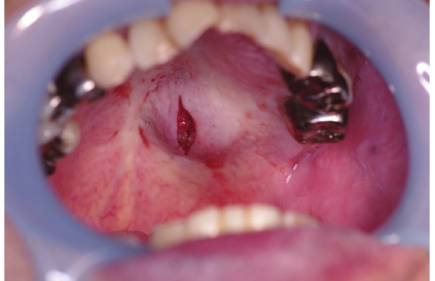
Figure 5: Intraoral findings after the first biopsy.